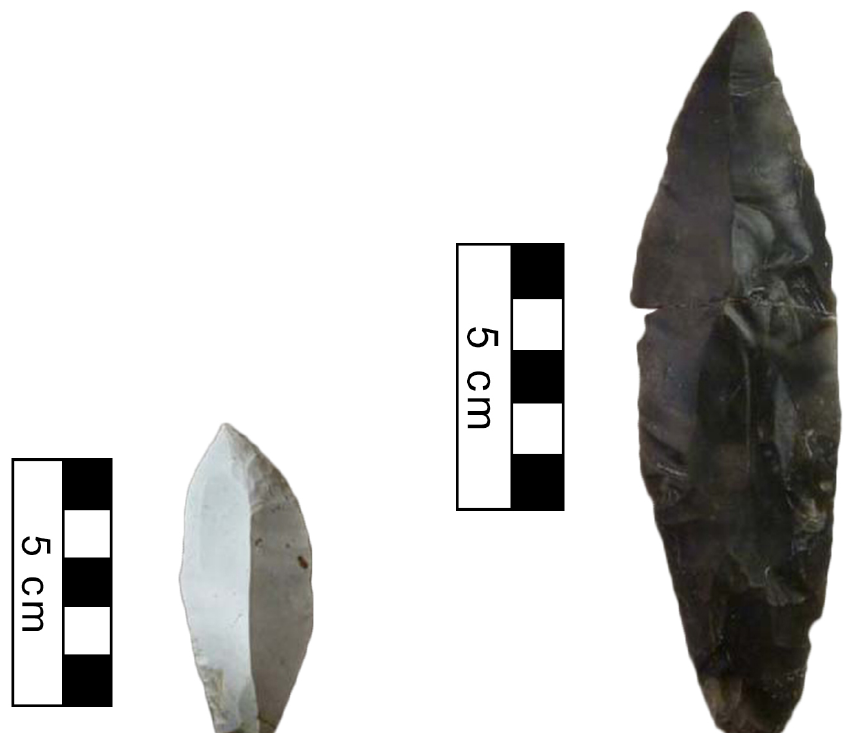
Figure 1. Archaeological blade-points recovered from Glaston, Leicestershire (left) and Beedings, Sussex (right) (photographs by the